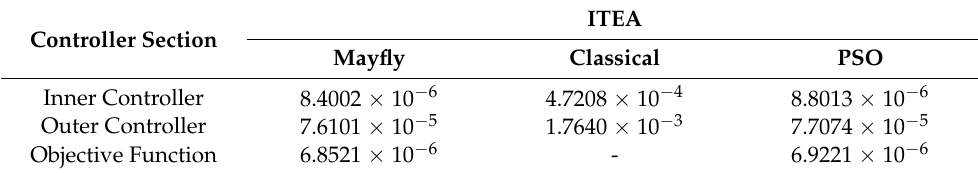
Table 7. Comparison of P.I. parameters’ efficiency in terms of